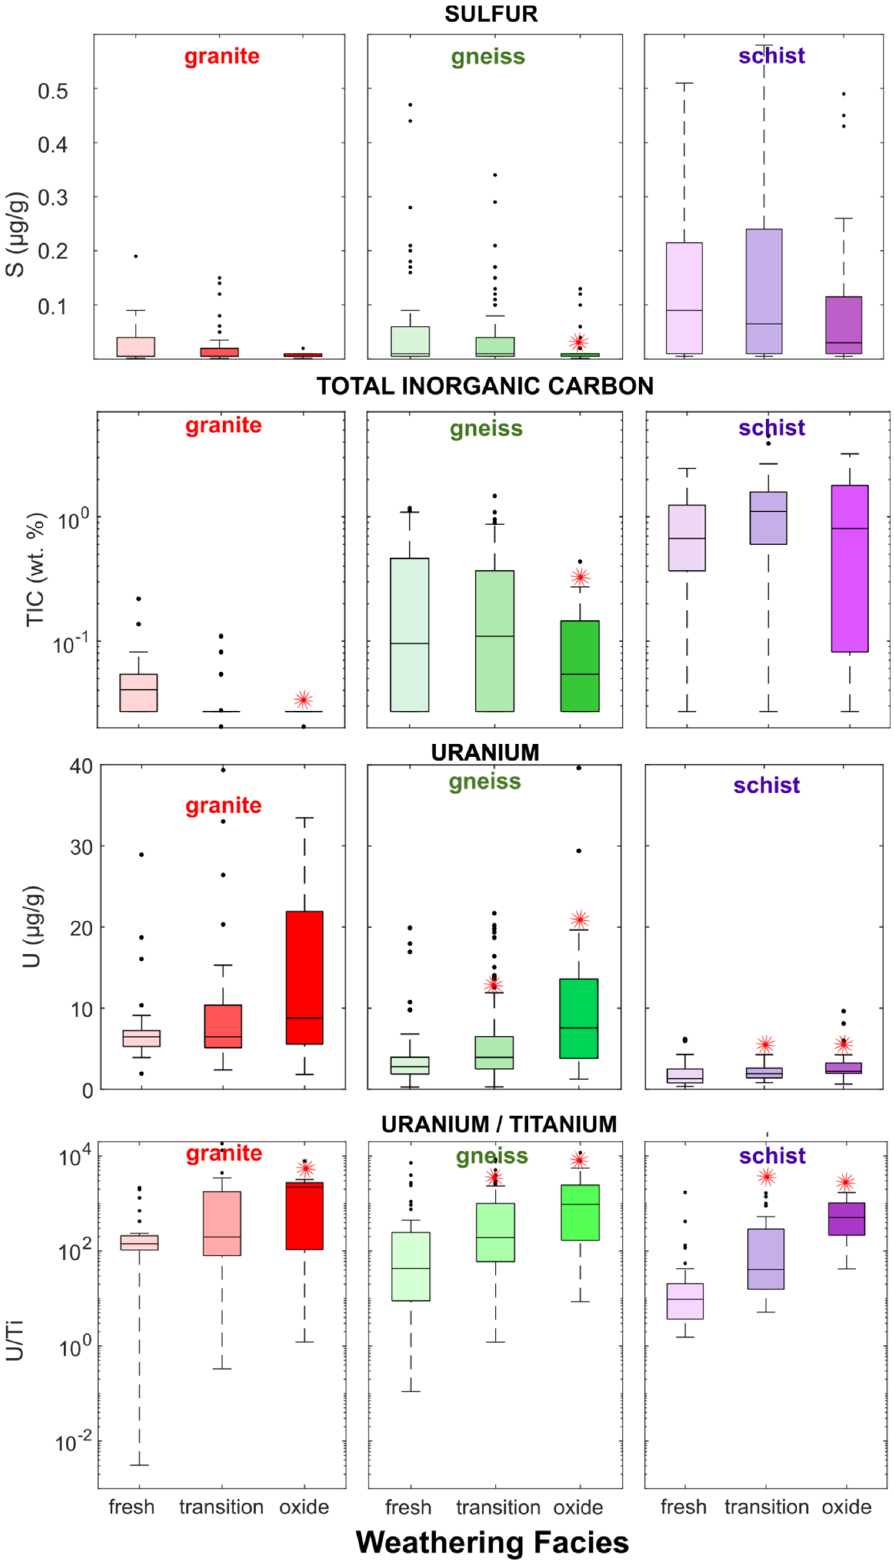
Figure 2. Sulfur, total inorganic carbon (TIC), U, and U/Ti by rock type and by weathering facies in Coffee drill-core samples. Red stars indicate median U or U/Ti is significantly higher ( p < 0.05); or TIC and sulfur content is significantly lower ( p < 0.05) in transition or oxide facies than in fresh facies for a given rock type (Mann–Wilcox Test).